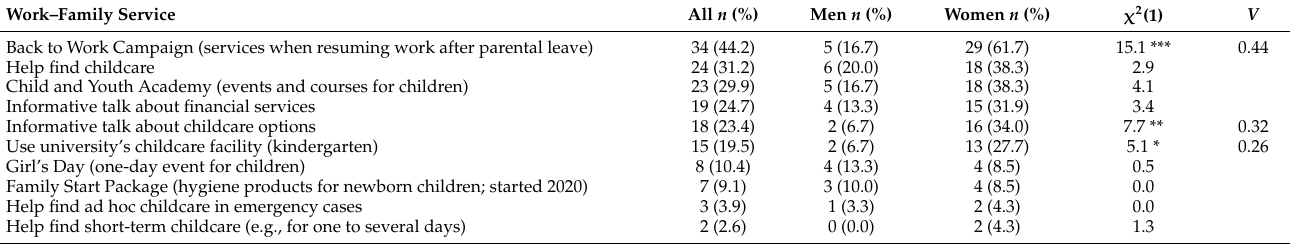
Table A1. Work–family services offered and used by women and men with at least one child below the age of 18 years ( n =